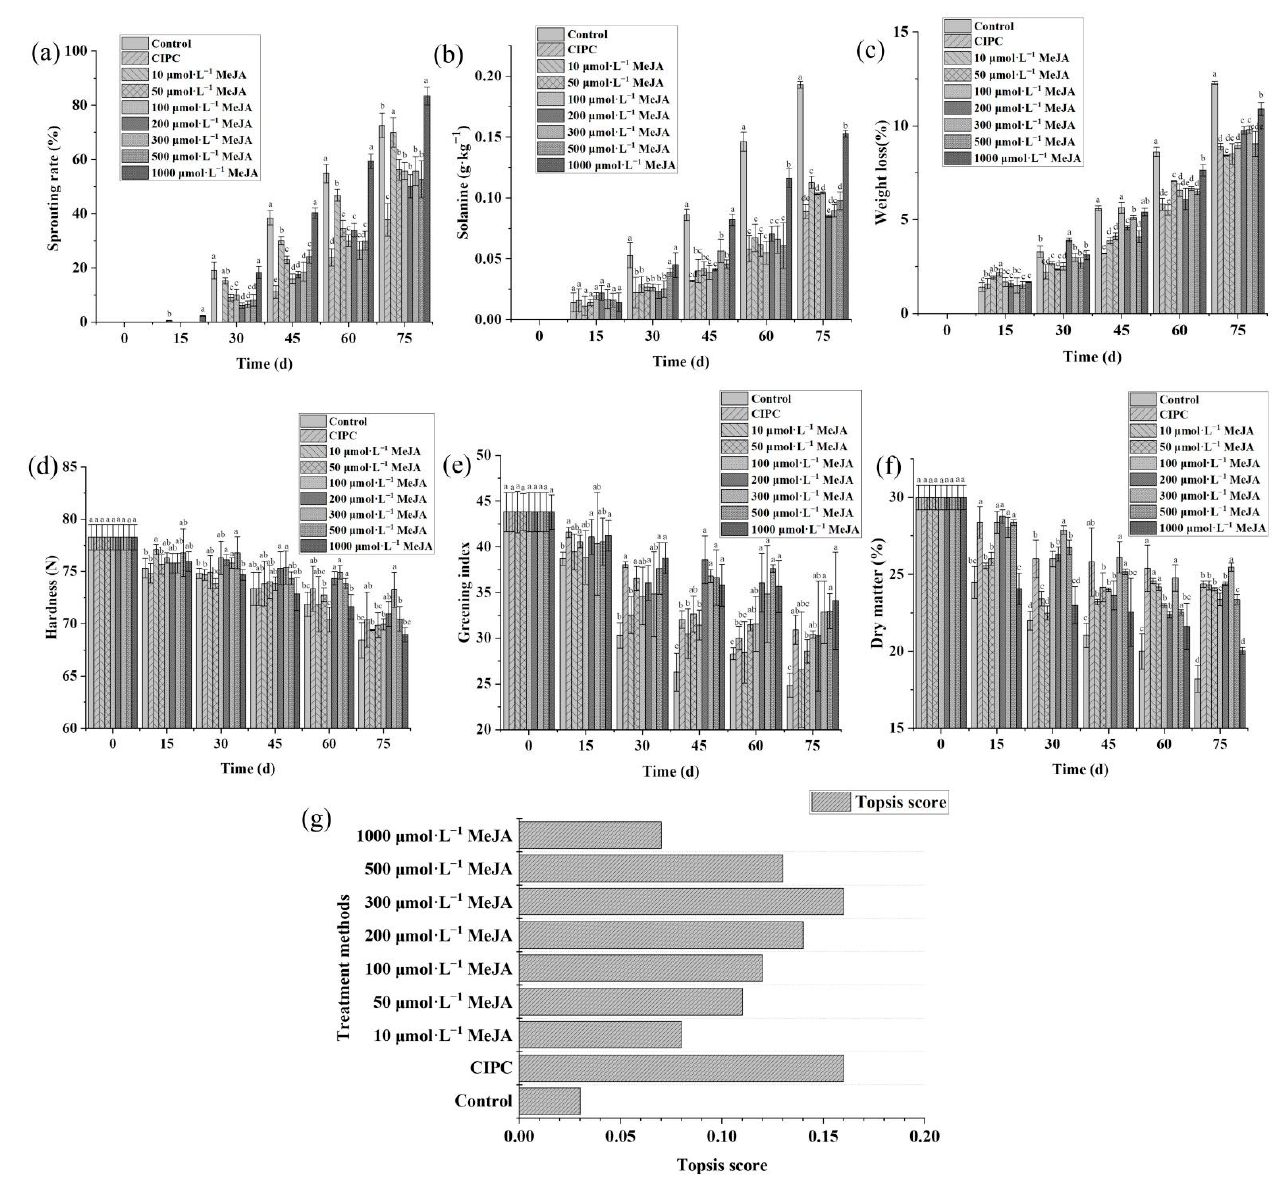
Figure 1. Methyl jasmonate could suppress sprouting and retain the quality of stored potato depending on the applied concentration. Sprouting rate ( a ), solanine content ( b ), weight loss ( c ), hardness ( d ), greening index ( e ), dry matter ( f ), TOPSIS score of the treatments based on these criteria ( g ). Multiple comparisons of the treatments using Turkey’s method ( p < 0.05) have been conducted, and treatments with no letters in common are significantly different.